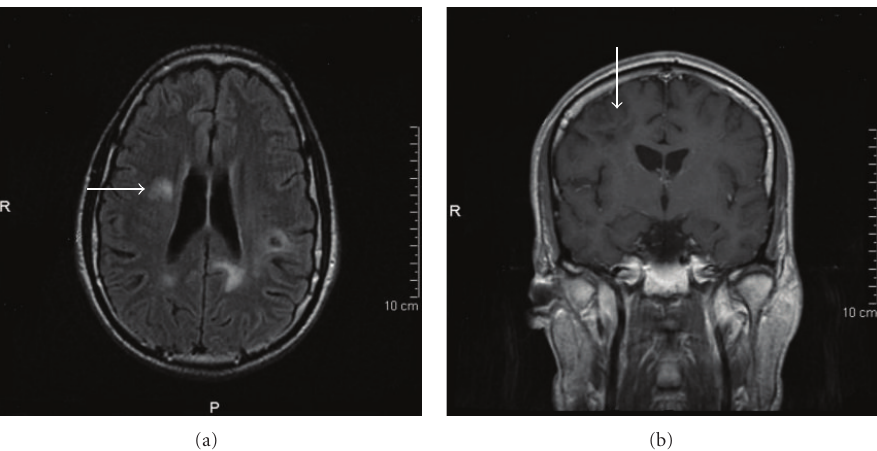
Figure 3: MRI scan after WBRT. After radiation therapy axial FLAIR image shows marked-size reduction of right-frontal mass (a) with no contrast enhancement in T1-weighted image after administration of gadolinium (b). According to International Revised Criteria for PCNSL Response Assessment, it was considered a complete response. Subsequent follow-up scans did not display any changes on remaining lesions and a FDG-PET scan undergone after completion of immunochemotherapy confirmed no residual tumoral